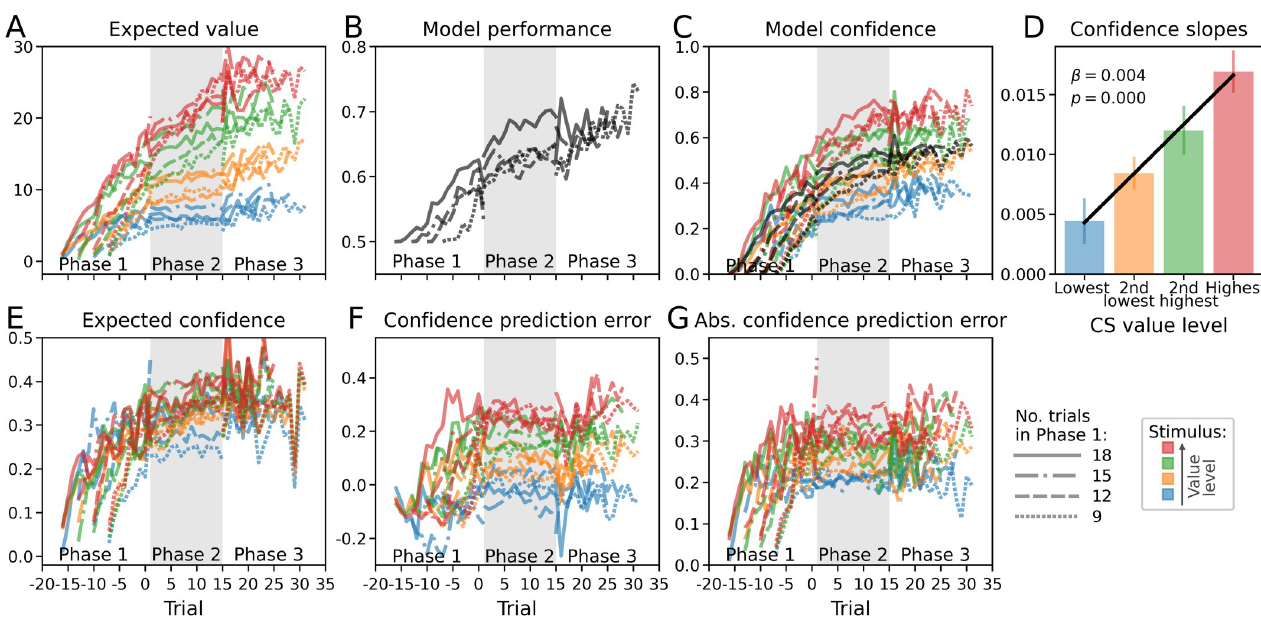
Fig 5. Latent variables and posterior predictive fits of model ConfUnspec . All time courses represent averages across blocks and subjects, split according to the duration of phase 1 (line styles) and the four CS value levels within a block (colors). (A) Expected values indicate current beliefs about the value of each stimulus. (B) Posterior predictive fit for model performance: expected proportion correct responses based on choice probabilities. (C) Posterior predictive fit for model confidence. Model confidence is computed based on the choice probability for the chosen CS (normalized to the range 0–1). Black lines indicate averages across value levels. (D) Confidence slopes of (C) in phase 2 in dependence of the CS value level. (E) Expected confidence corresponds to an integration of past confidence experiences using a Rescorla-Wagner-type learning rule. (F) Confidence prediction errors indicate the deviation of a momentary confidence experience from expected confidence. (G) Absolute confidence prediction